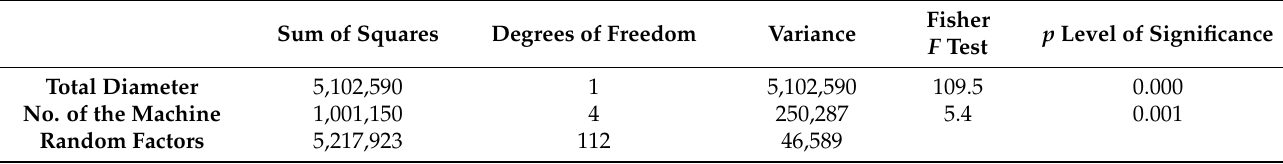
Fisher p Level of Significance F Test